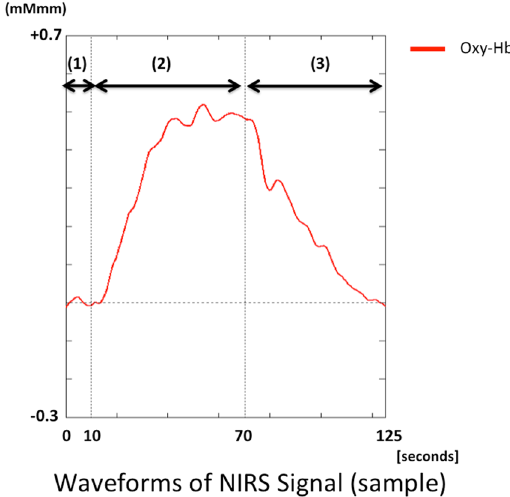
Figure 6. Time-dependent changes in oxy-hemoglobin (oxy-Hb) concentration in an NIRS signal waveform (sample). The average waveforms of time-dependent changes in mean oxy-Hb concentrations in the channels. (1) 10-s pre-task baseline period (2) 60-s activation period (3) in the 55-s post-task baseline